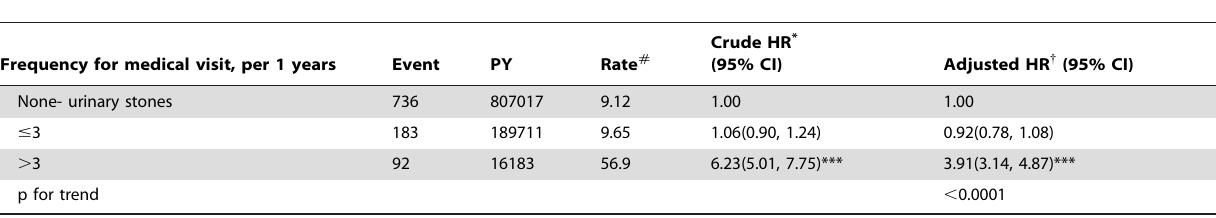
Table 3. The risk of ACS among frequency for medical visits of stones in Cox proportional hazard regression.